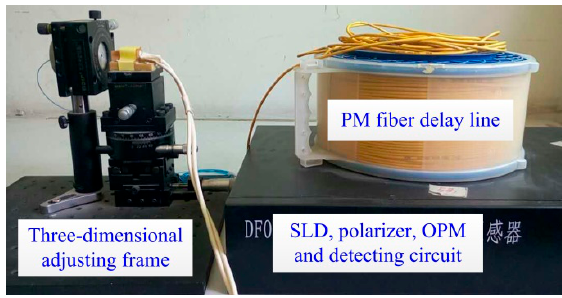
Figure 7. The experimental setup of FR axis-angle measurement.